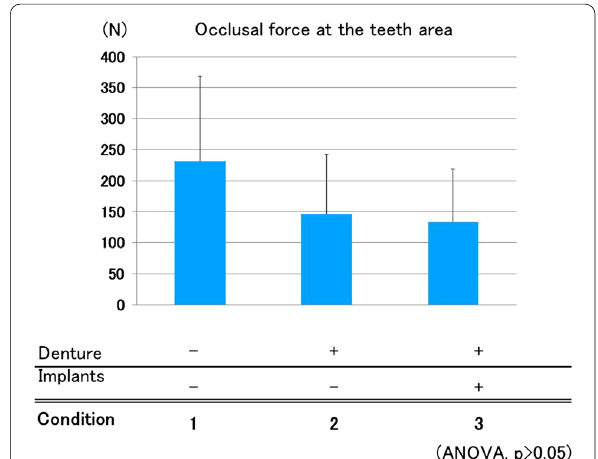
Fig. 5 Occlusal force at tooth area. There were no significant differences in occlusal force at the tooth area among the three conditions